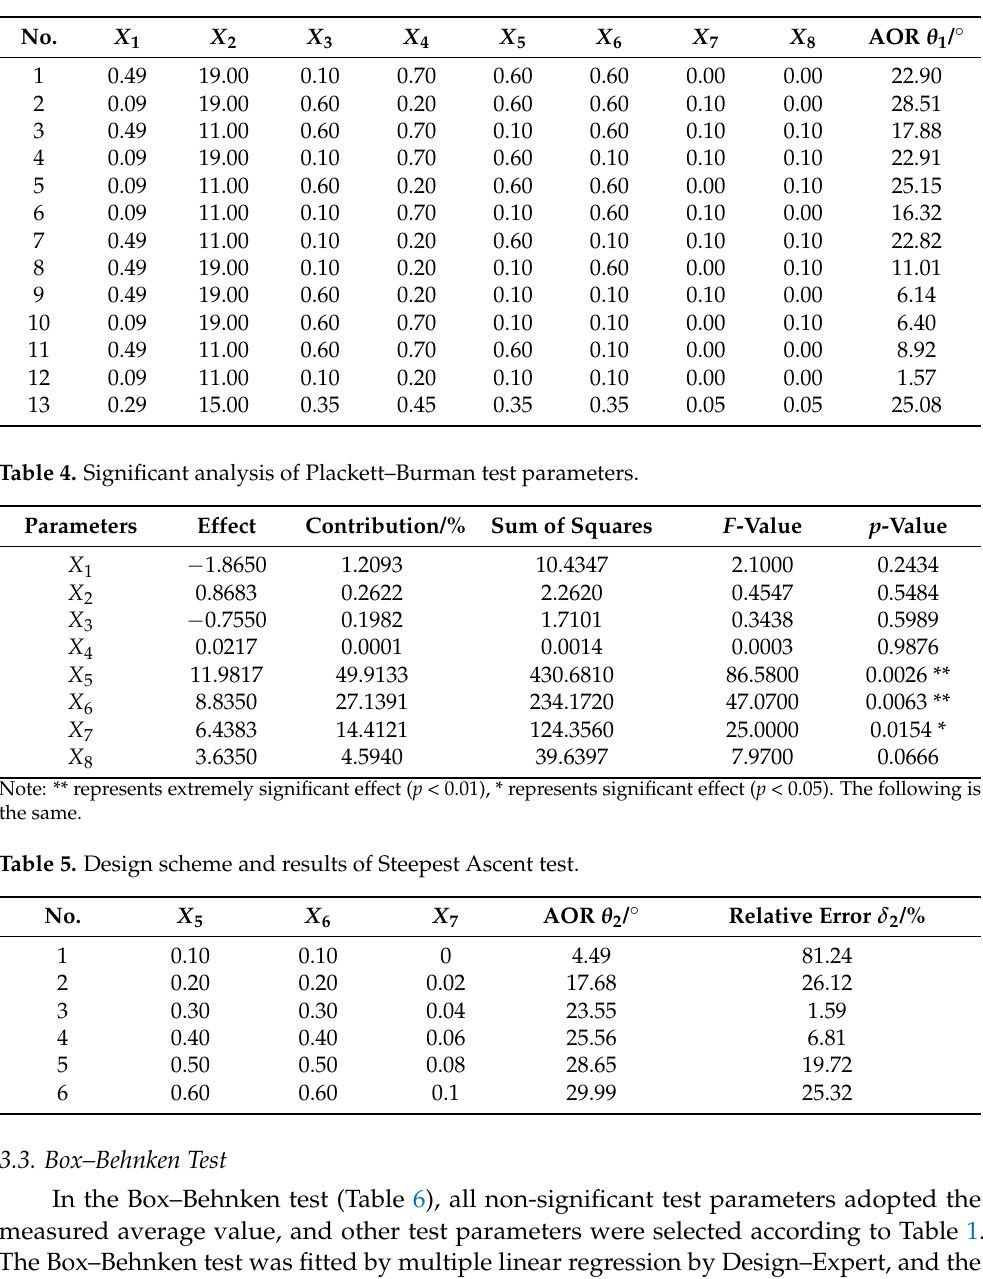
Table 3. Design scheme and results of Plackett–Burman test.